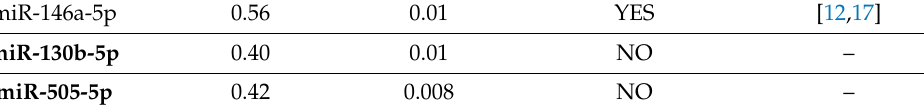
Previously Reported in